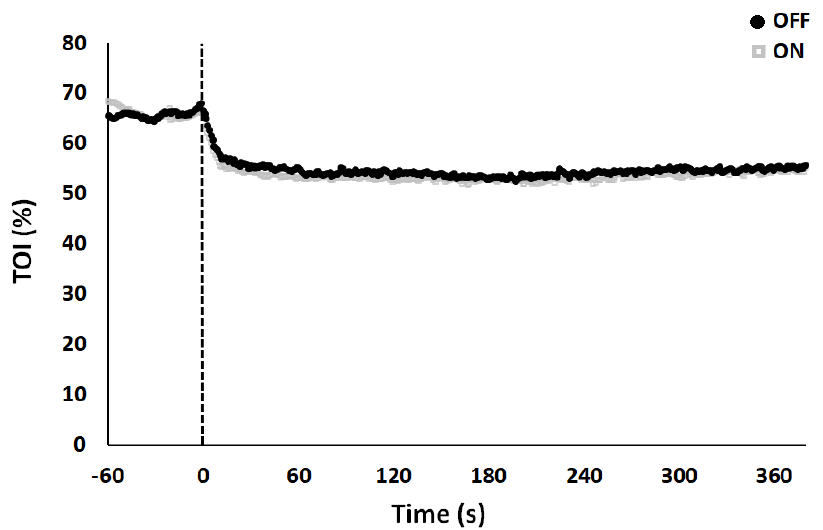
Figure 3. Vastus lateralis tissue oxygenation index (TOI) kinetics following acute PEMF stimulation (ON) and sham condition (OFF). Vertical dotted line at time 0 represents the transition from unloaded pedaling (baseline at 0 W) to constant-load exercise. Data points are average values (%) calculated each second.